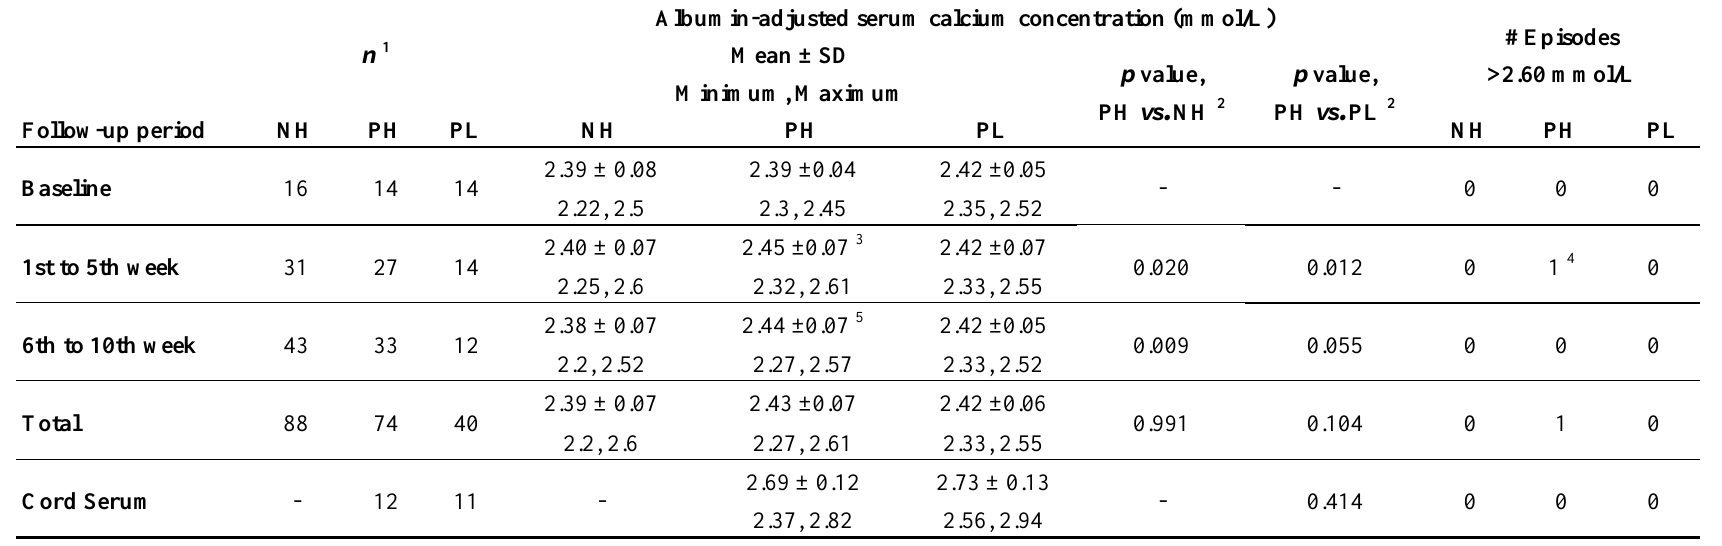
Table 4. Albumin-adjusted serum calcium concentration at baseline, the 1st to 5th week of follow-up, and the 6th to 10th week of follow-up in non-pregnant women who received an initial dose of 70,000 IU vitamin D3 and 35,000 IU/week (NH), pregnant women who received an initial dose of 70,000 IU vitamin D3 and 35,000 IU/week (PH), and pregnant women who received 14,000 IU/week